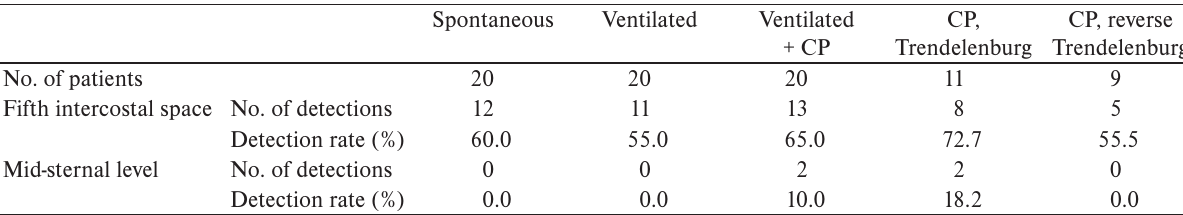
Table 2. The positive diaphragm detection at the fifth intercostal space and at the mid-sternal level for spontaneously breathing patients (Spontaneous), for mechanically ventilated patients under general anesthesia with muscle relaxation (Ventilated) and for mechanically ventilated patients under general anesthesia with muscle relaxation and capnoperitoneum (Ventilated + CP) divided into patients undergoing surgery in the Trendelenburg position (CP, Trendelenburg) and reverse Trendelenburg position (CP, reverse Trendelenburg).